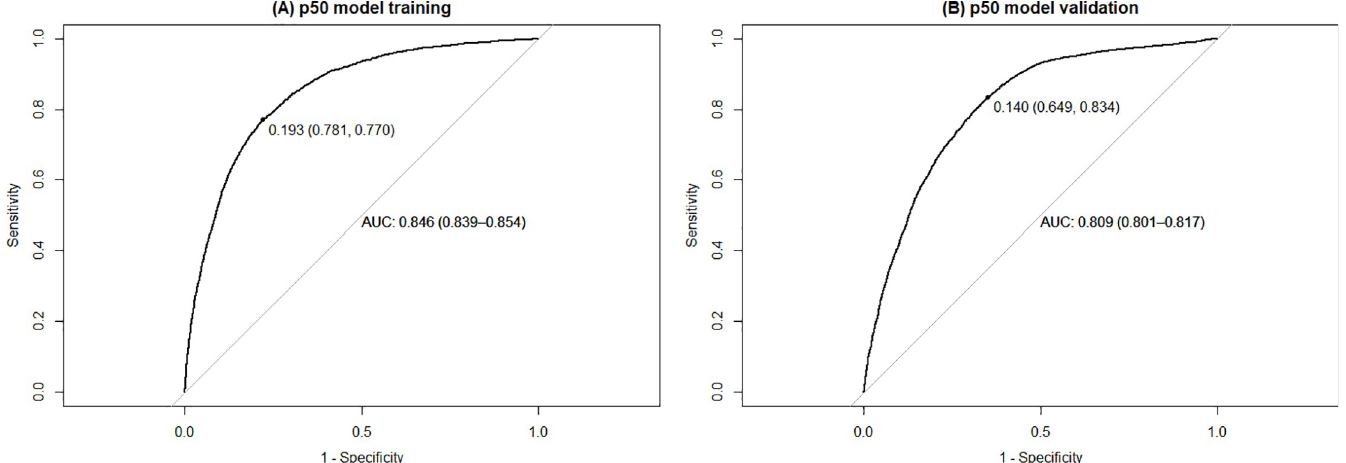
Fig 1. Performance of the patient no-show predictive model developed on 50% (p50) of the dataset. (A) shows the AUC (95% confidence interval) of the p50 model tested on the same subset from which it was developed (training subset). (B) shows the AUC (95% confidence interval) of the p50 model tested on the remaining 50% of the dataset (validation subset). The point in the curve is the threshold that maximizes the sensitivity and specificity of the model. The sensitivity and specificity are in the parenthesis. AIC: Akaike Information Criteria. AUC: area under the Receiver Operating Characteristic curve.